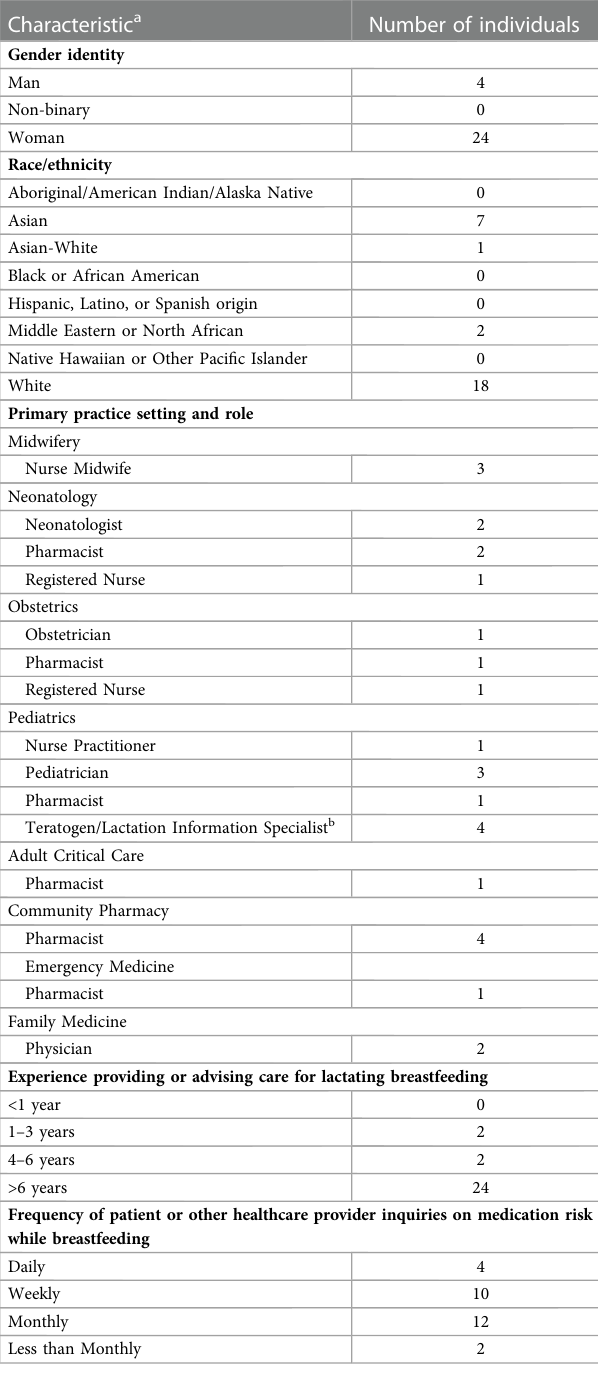
TABLE 1 Study participant